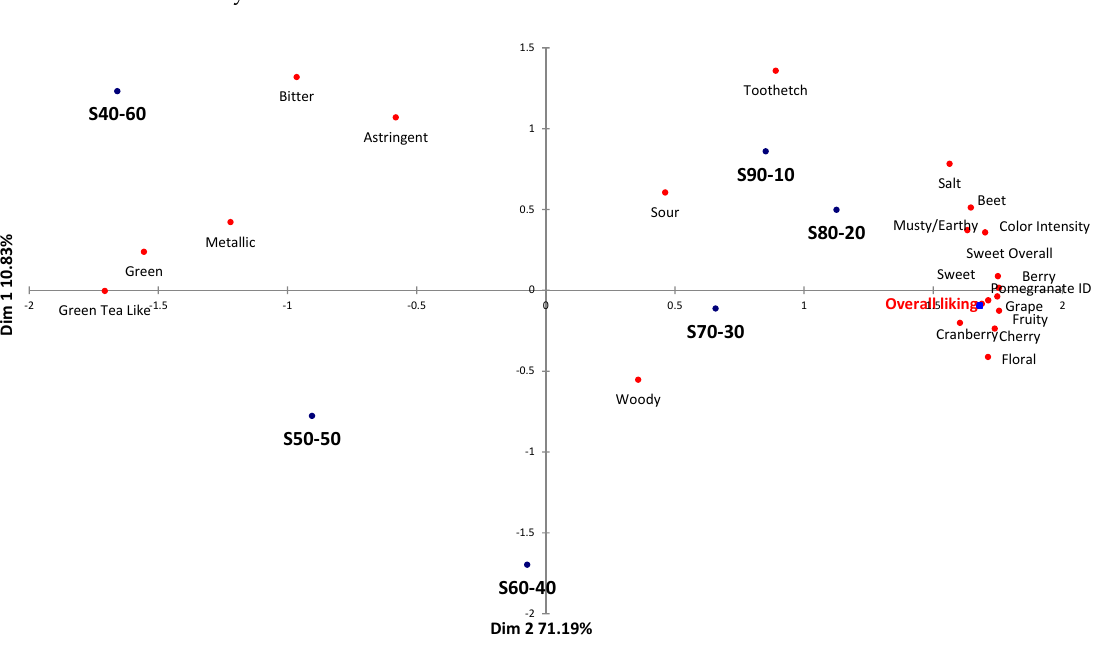
Figure 2. Preference Mapping of samples with dimensions 1 and 2 for the six PJ–GT samples and 21 descriptive attributes.